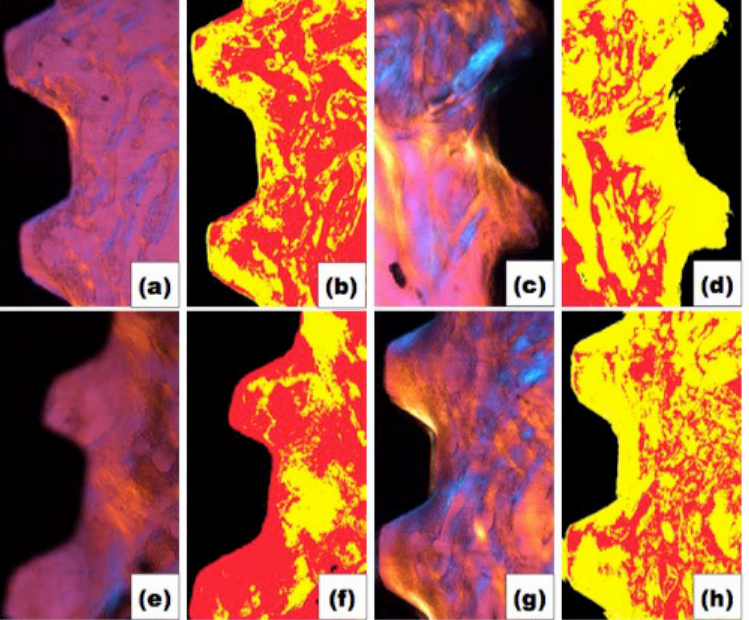
Figure 4. Original and segmented images of each group. ( a , b ). Regular instrumentation without rhBMP-7; ( c , d ). Regular instrumentation with rhBMP-7; ( e , f ). Over-instrumentation without rhBMP-7; ( g , h ). Over-instrumentation with rhBMP-7. Colors: BLACK—implant; RED—connective tissue; YELLOW—new bone formation.